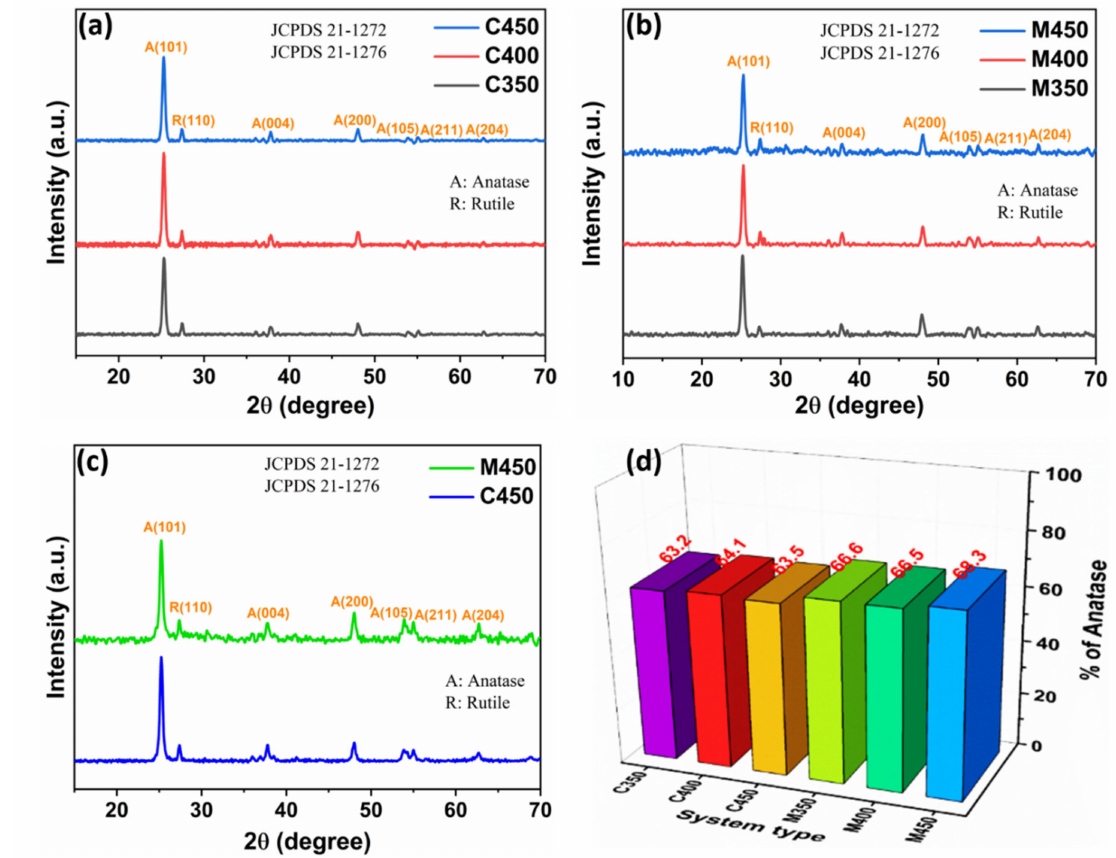
Figure 1. XRD patterns of ( a ) Conventional, ( b ) Microwave sintered titania films, ( c ) Conventional and microwave sintered films at 450 ◦ C, and ( d ) Percentage of anatase phase.